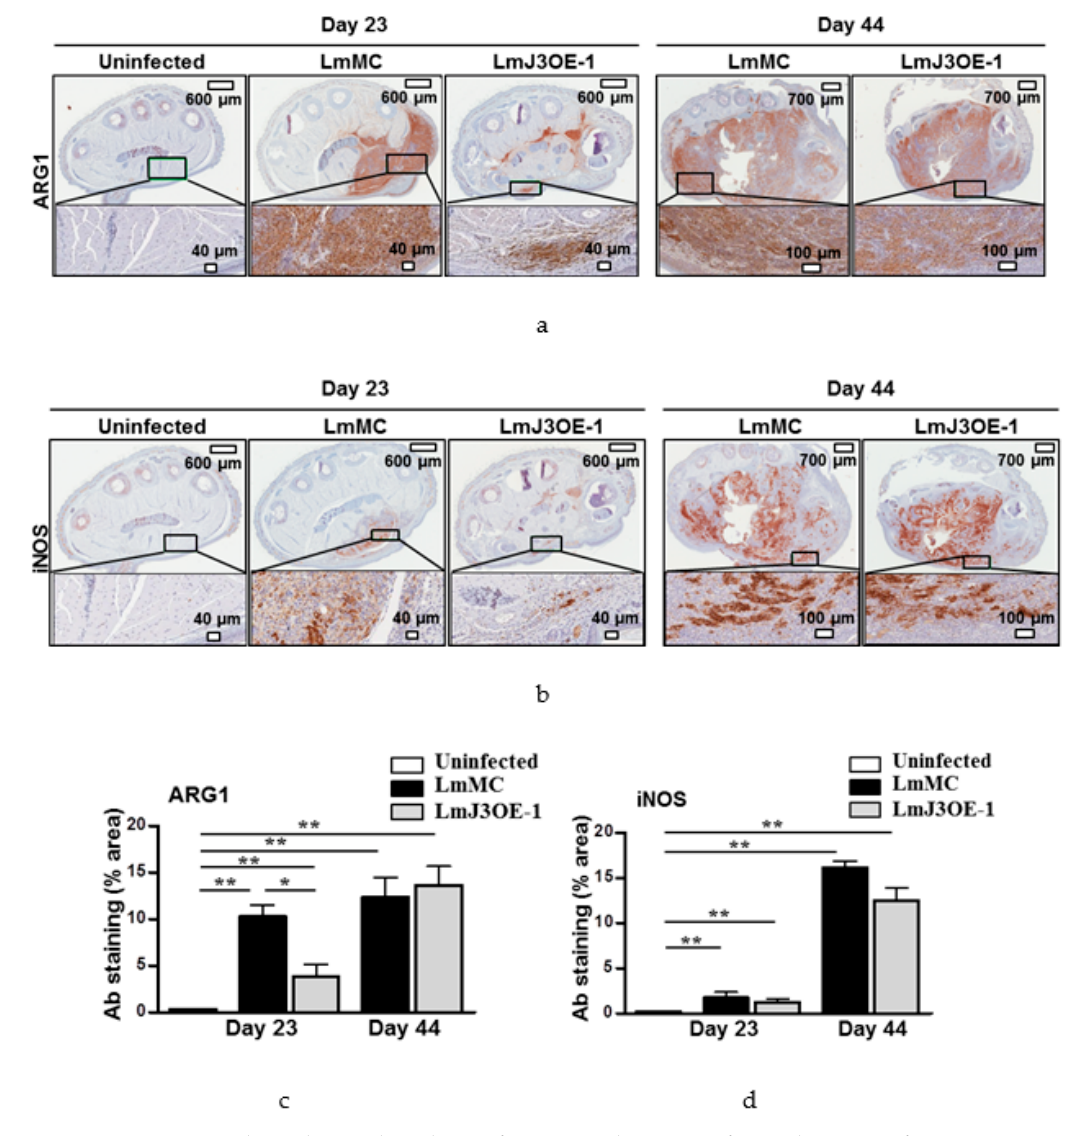
Figure 7. Immunohistochemical analysis of ARG1 and iNOS in footpad sections from LmJ3OE- and LmMC-infected mice. Footpad sections stained with ( a ) ARG1 and ( b ) iNOS antibodies from uninfected mice compared to both L. major overexpressing LmjF.22.0810 (LmJ3OE-1) and L. major control (LmMC)-infected animals. The differences in the area of footpad sections stained with antibodies of ( c ) ARG1 and ( d ) iNOS from LmJ3OE-infected mice compared to uninfected and LmMC-infected mice are illustrated. Bars represent the means (± SD) (* p < 0.05, ** p < 0.01).